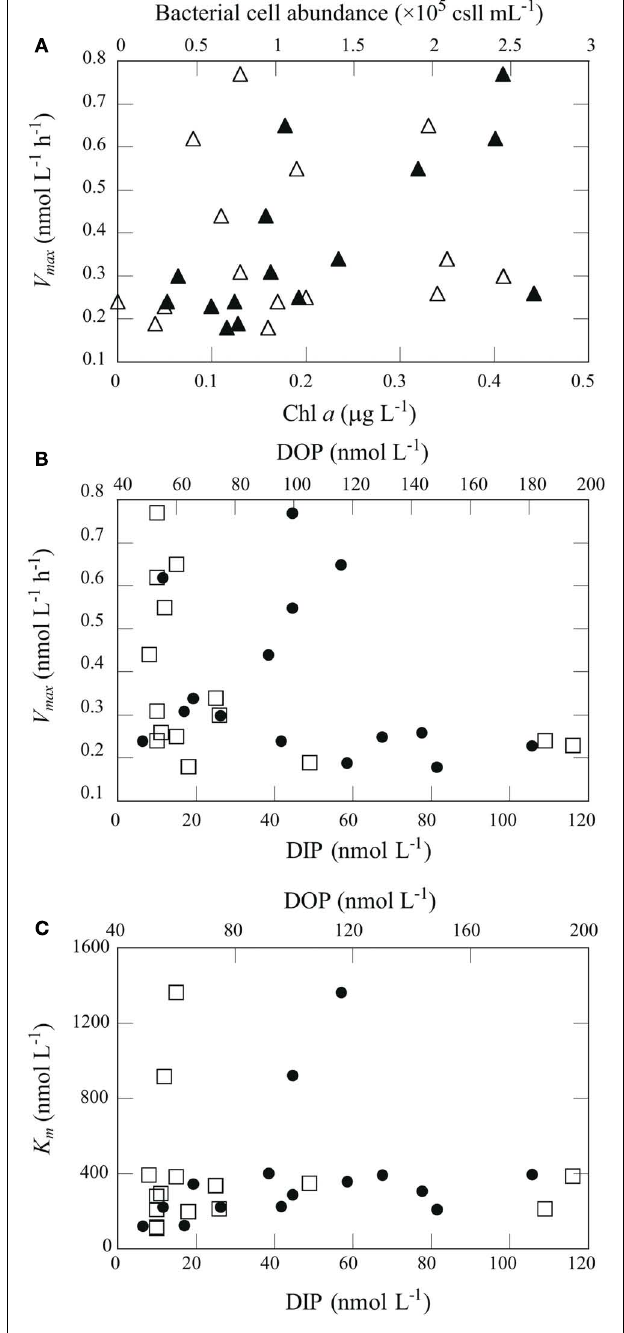
FIGURE 6 | Relationships between chemical and biological variables in seawater andAPA kinetic parameters. (A) Relationship between V max and Chl a concentration (open triangles) and bacterial abundance (filled triangles). (B) Relationship between V max and DIP (open squares) or DOP (filled circles). (C) Relationship between K m and DIP (open squares) or DOP (filled circles).